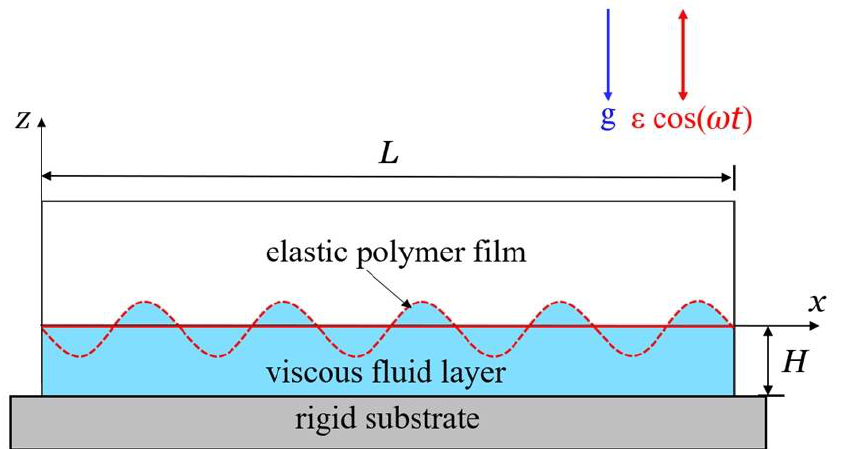
Figure 1. Schematic illustration of Faraday instability of a viscous fluid layer covered with an elastic polymer film. The length of container is L , and the thickness of viscous fluid layer is H . The bending stiffness and thickness of the elastic polymer film are B and t , respectively. The container is placed on a rigid substrate, and subjected to its own weight and a vertical sinusoidal acceleration with amplitude ε and frequency ω